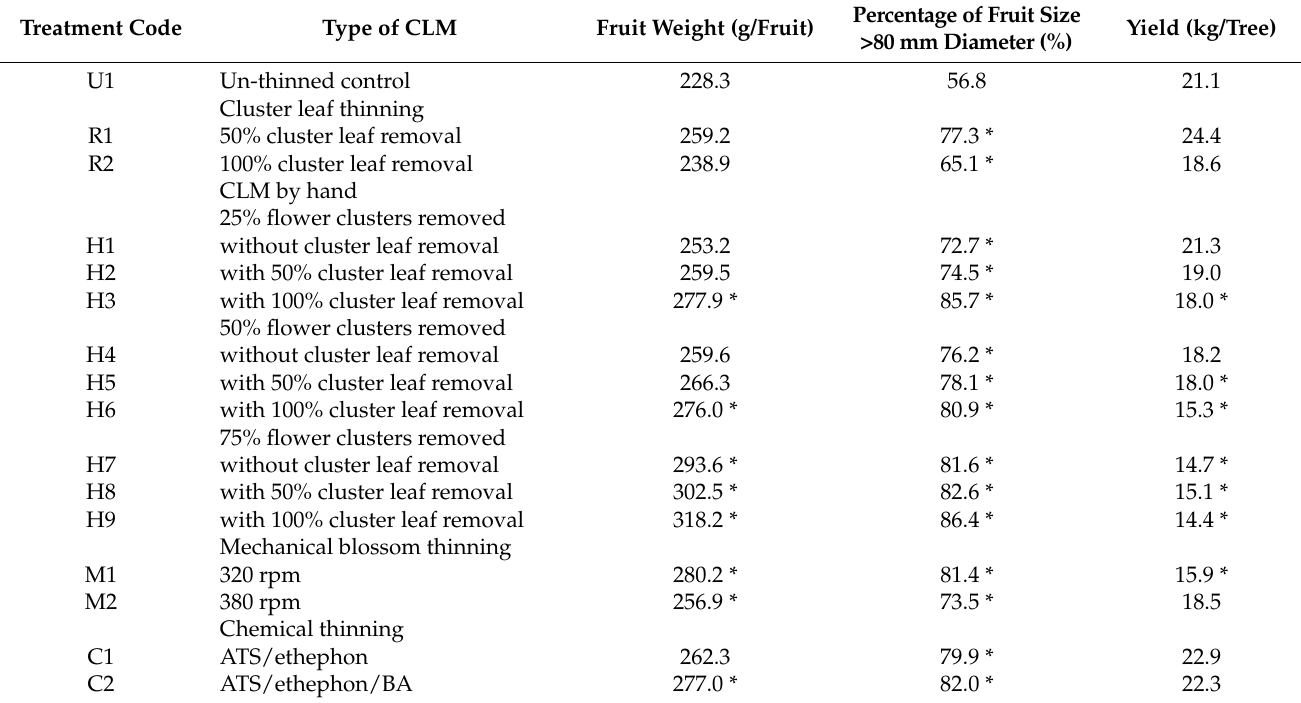
Table 4. Effect of thinning treatment on fruit weight, fruit size distribution expressed as percentage of total yield and yield per tree, cv. ‘Roter Boskoop’ in